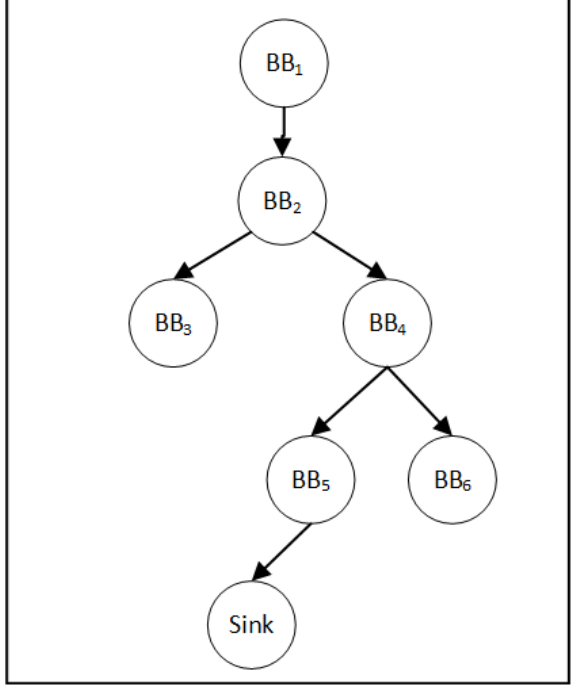
Figure 6 . Sample control flow graph of potentially vulnerable